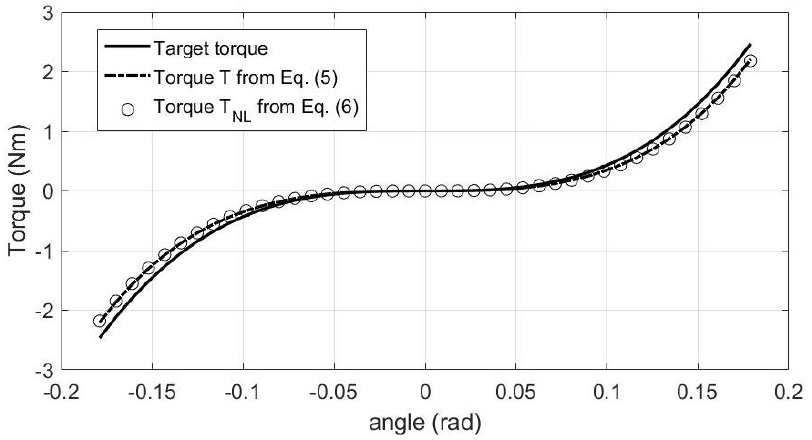
Figure 6. Target torque ( 𝑘 3 = 430 Nm/rad 3 ) versus theoretical torque model of the NES given by Equation (5) and corresponding Taylor expansions up to 5th order given by Equation (6).